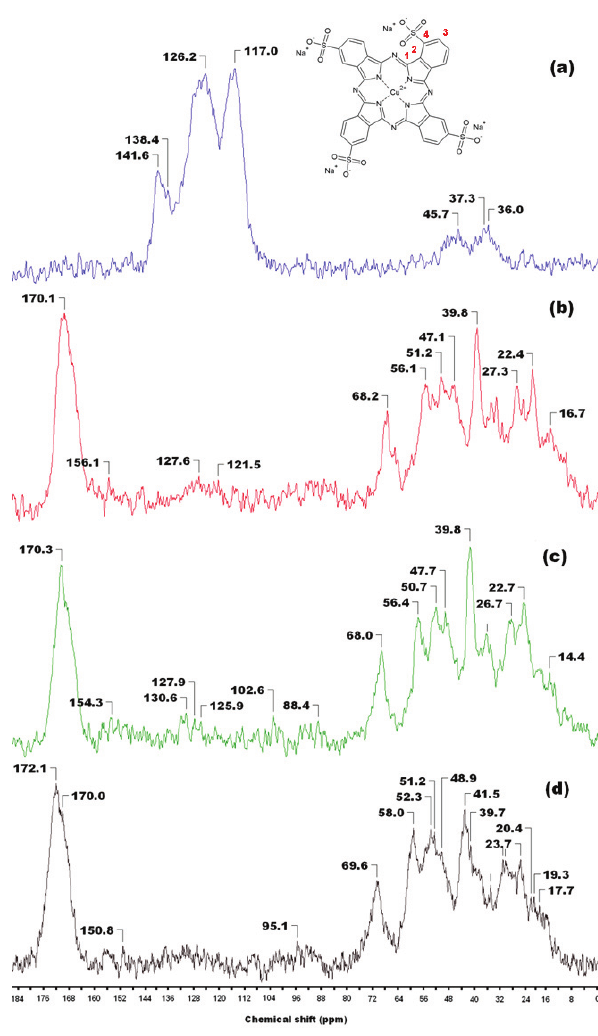
Figure 3: 13 C NMR spectra of CuPC (a), sample 1 (pH=2, 120 min, 500 mg/L) (b), sample 2 (pH=2, 120 min, 400 mg/L) (c), H. communis skeleton (d) and chemical structure of copper phthalocyanine- 3,4′,4″,4″′-tetrasulfonic acid tetrasodium salt